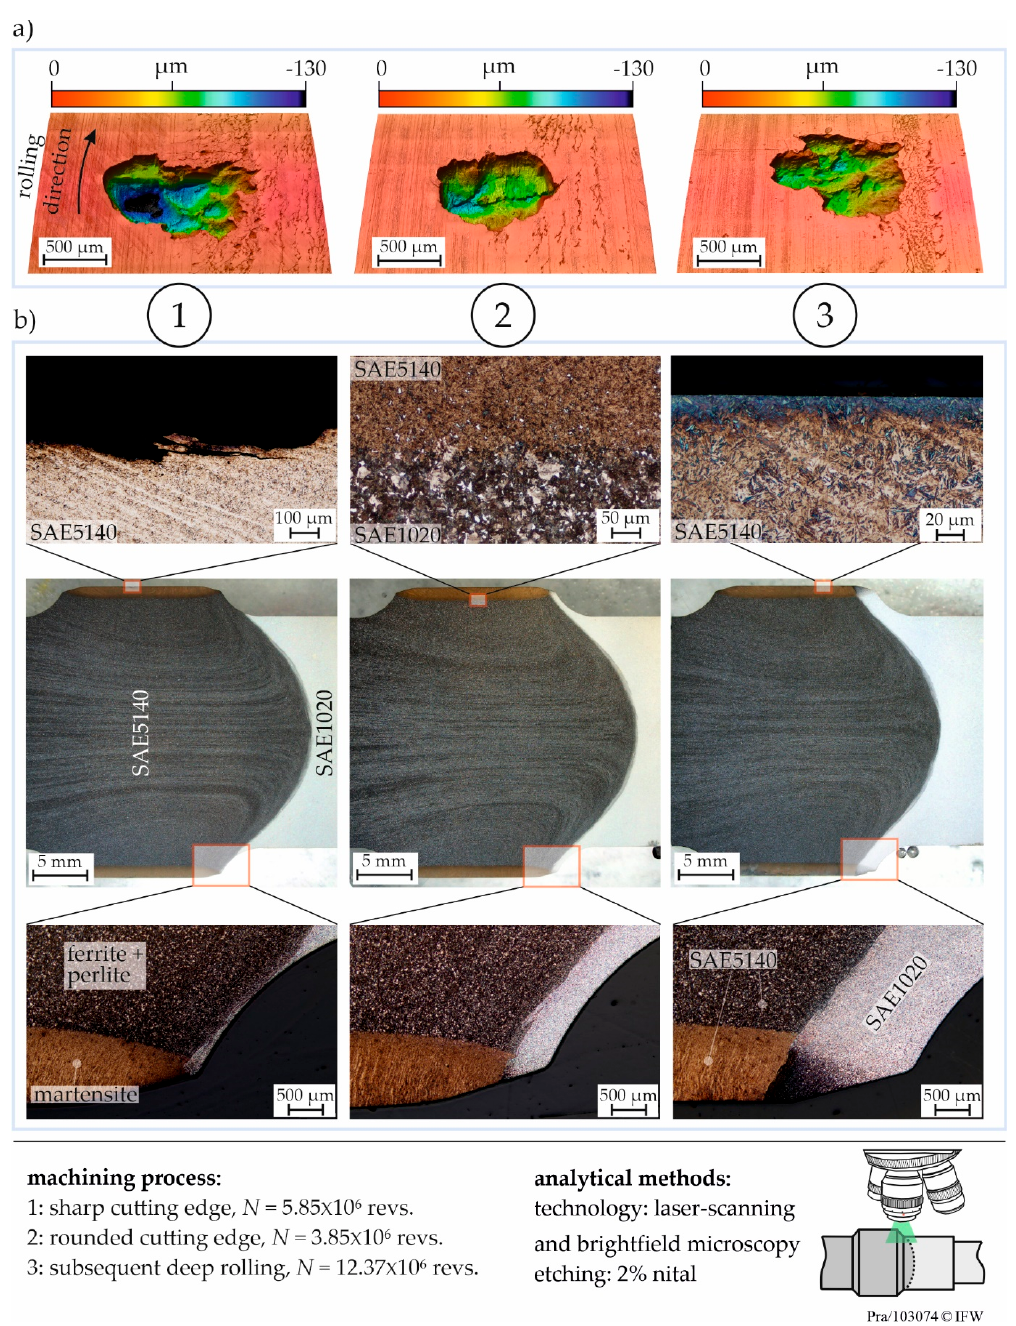
Figure 9. Damage analysis: ( a ) surface laser scanning microscopy of each event-relevant spalling damage, and ( b ) microstructural details in axial section plane.